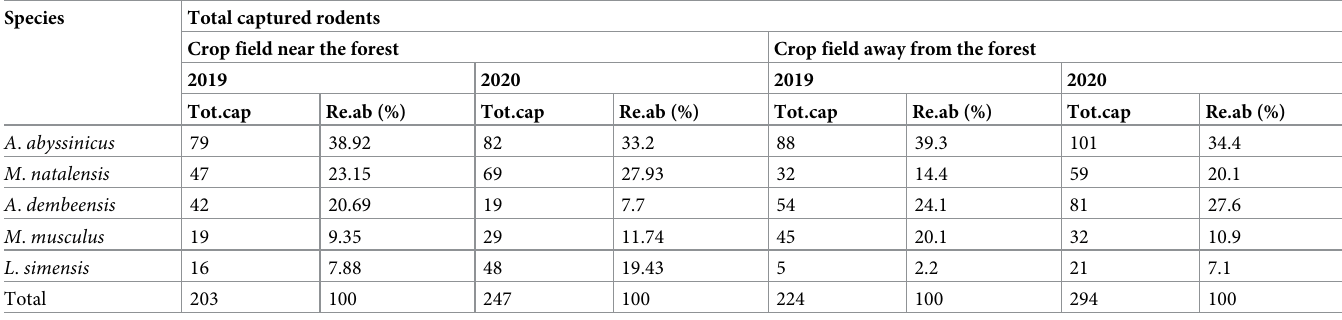
Tot.cap = Total captured; Re.ab = Relative